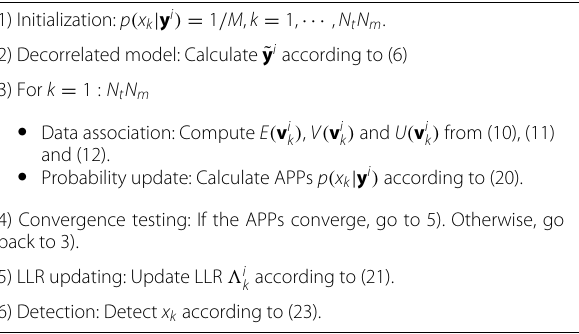
Table 1 The summary of PDA